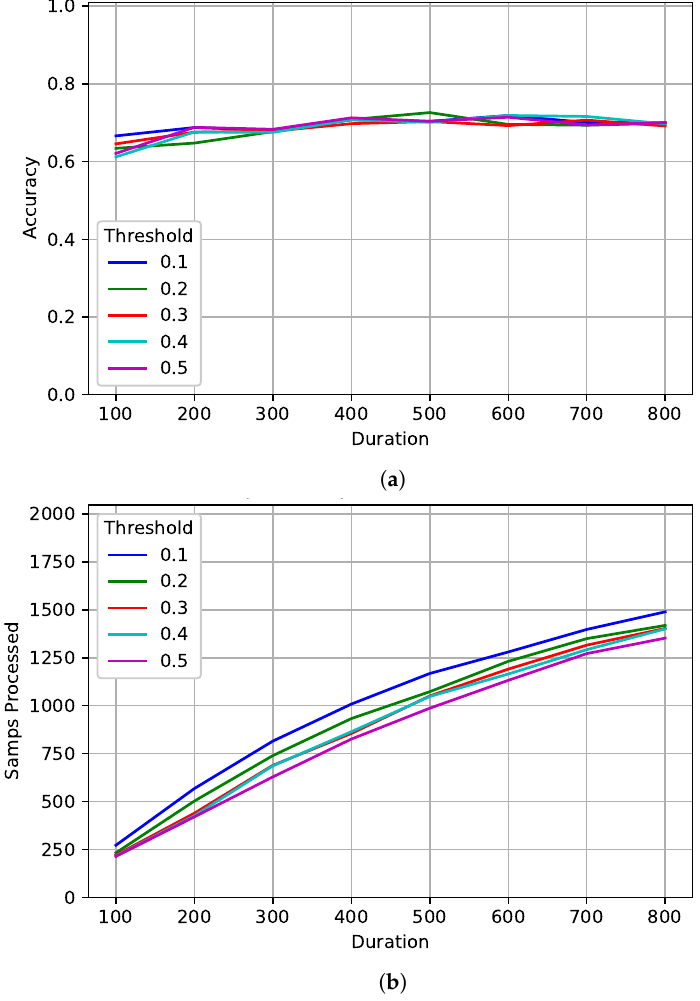
Figure 11. A tradeoff analysis of ( a ) accuracy and ( b ) the number of samples processed of the different JED parameters for the best models trained on 128 samples.